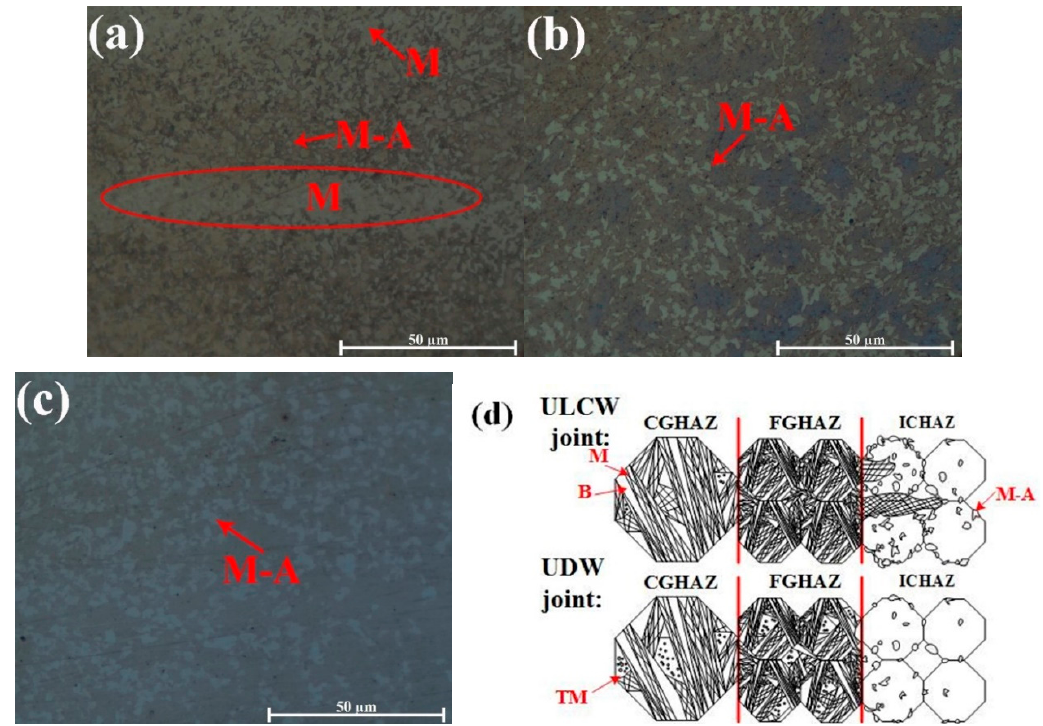
Figure 7. M-A constituents revealed by Lepera etchant: ( a ) the starting region of the ICHAZ-ULCW joint; ( b ) the tail region of the ICHAZ-ULCW joint; ( c ) ICHAZ-UDW joint; ( d ) the distribution of M and M-A components within HAZs.